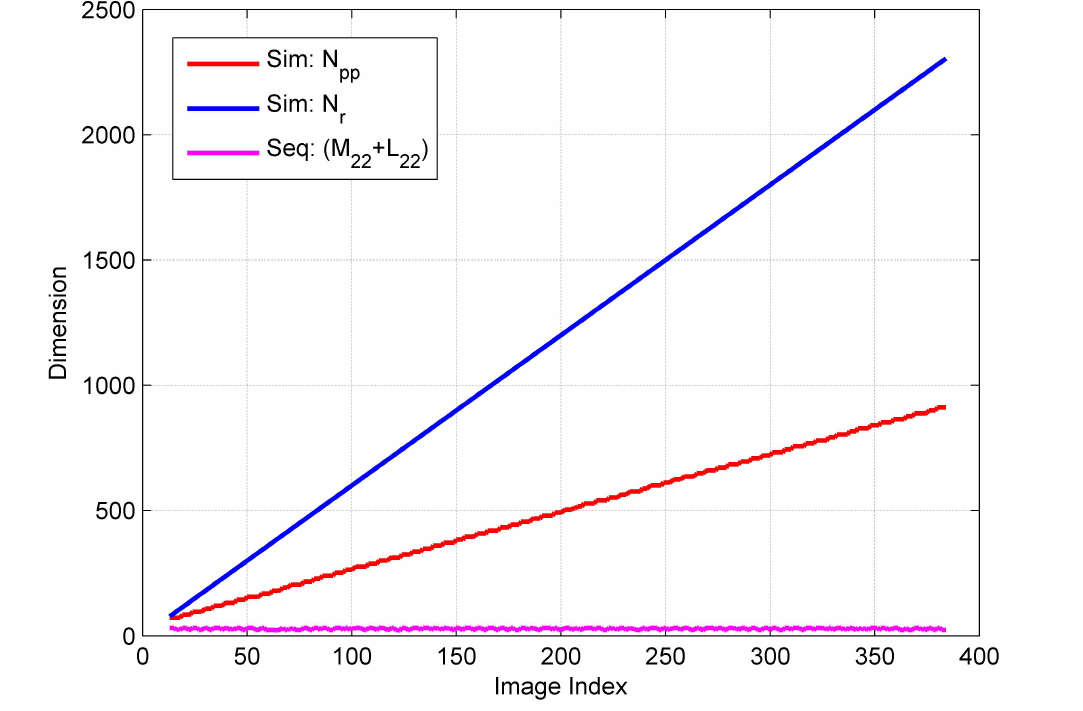
Figure 9. Dimension of the inverse matrices to be